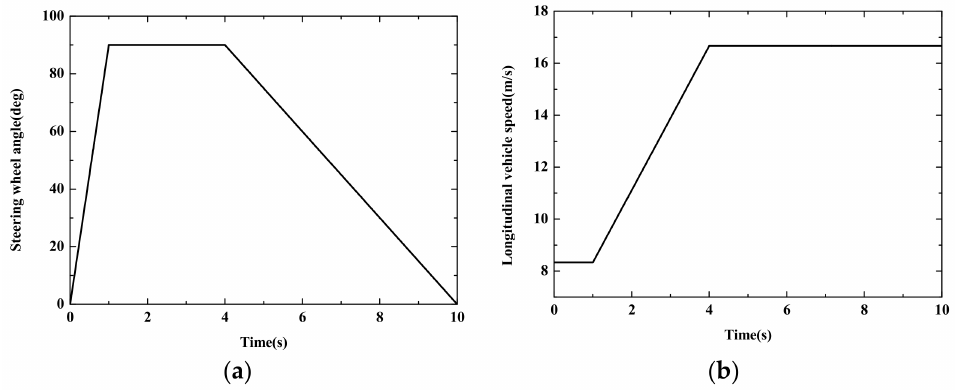
Figure 9. Simulation results of Case 2. ( a ) Steering wheel angle; ( b ) Longitudinal vehicle